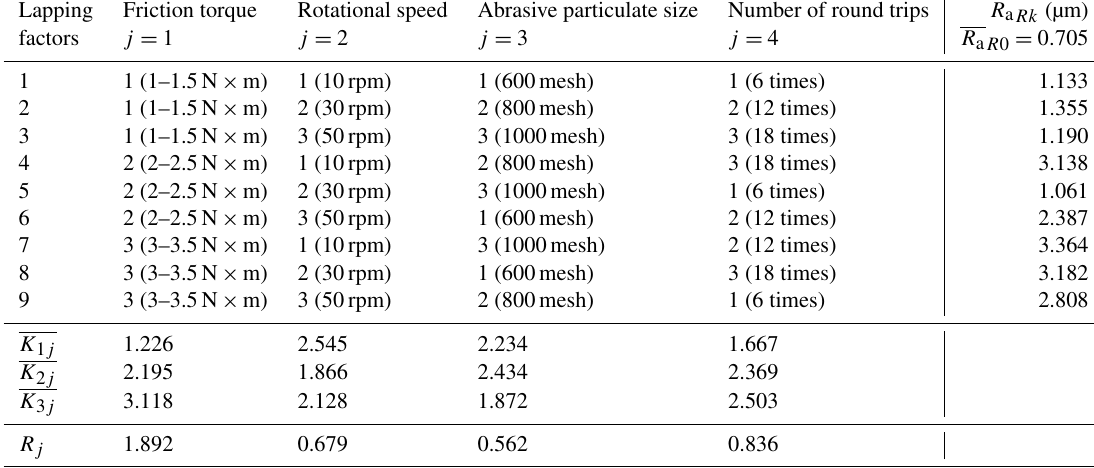
Table 5. Surface roughness of right arc. Lapping Friction torque Rotational speed Abrasive particulate